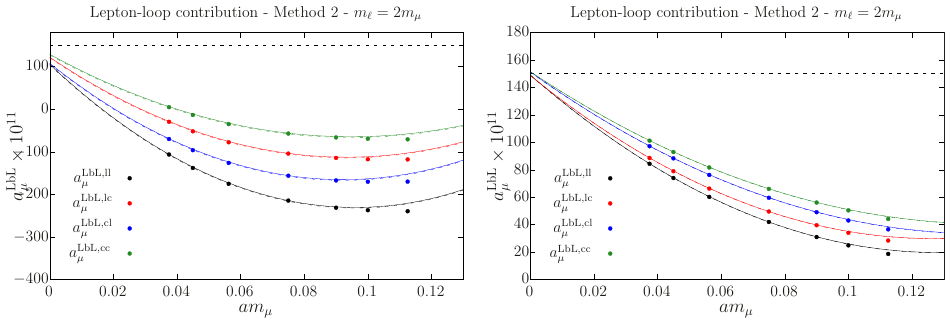
Figure 11 . Continuum extrapolation of the lepton loop contribution for the two kernels L (0) (left panel) and L (2) (right panel) using Method 2. We use m l = 2 m µ . The colors correspond to different discretizations of the correlation function. The horizontal dashed line represents the exact result.